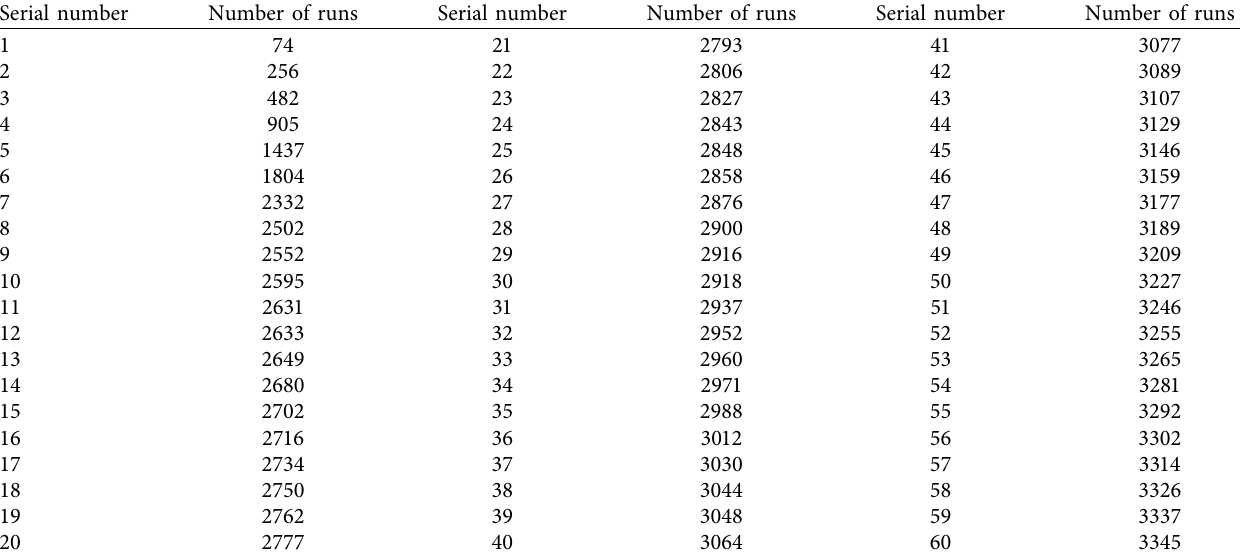
Table 1: Operating data sheet of low-temperature globe